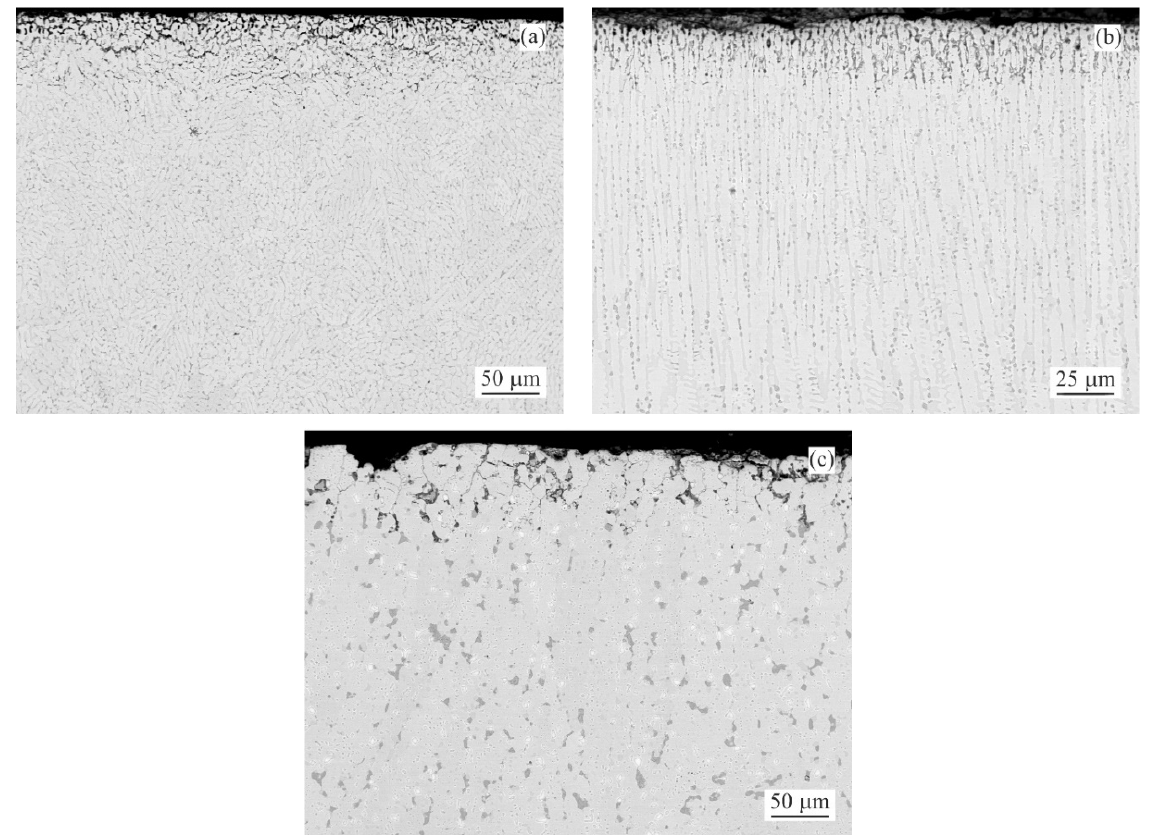
Figure 6. BSEM images indicating the extent of IG corrosion observed for the annealed samples: ( a ) MZ + 0.0Sn ( b ) MZ + 0.5Sn ( c ) MZ + 3.0Sn.